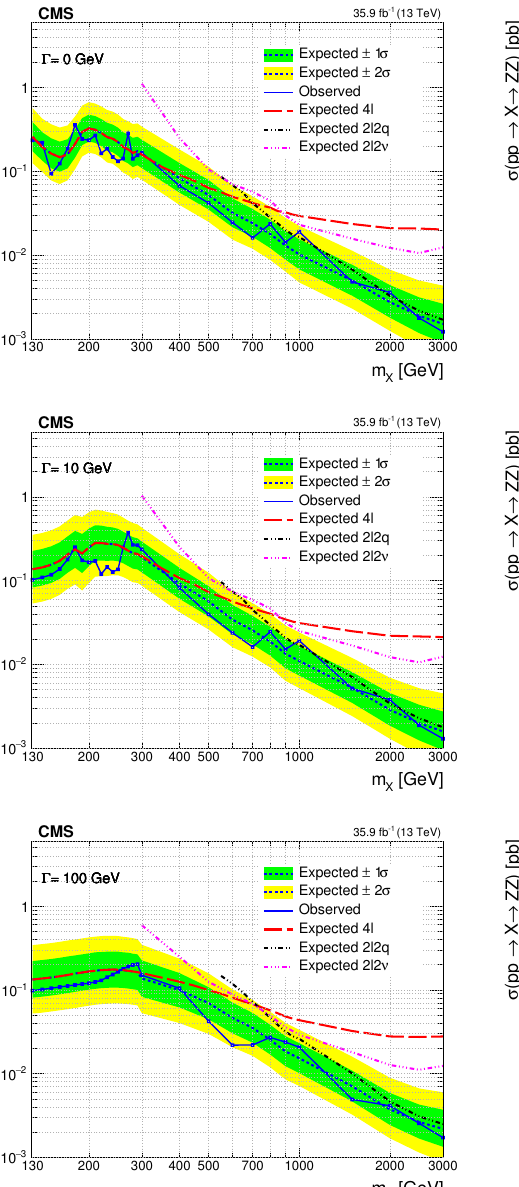
Figure 10 . Expected and observed upper limits at the 95% CL on the pp ! X ! ZZ cross section as a function of m X and for several (cid:0) X values with f VBF as a free parameter (left) and (cid:12)xed to 1 (right). The results are shown for 4 ‘ , 2 ‘ 2q, and 2 ‘ 2 (cid:23) channels separately and combined. The reported cross section corresponds to the signal only contribution in the absence of